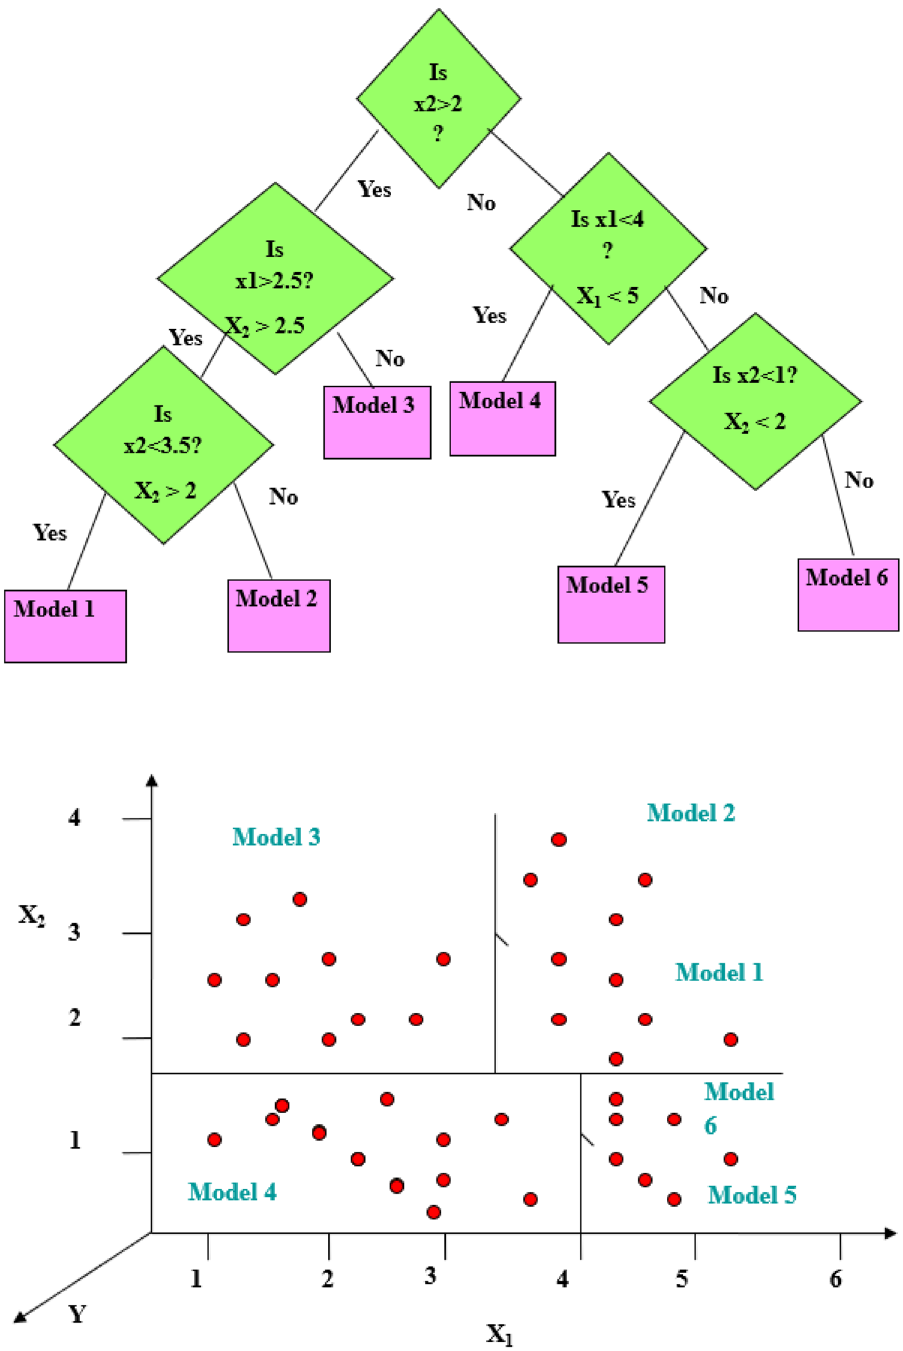
Figure 3. Schematic structure of M5 tree